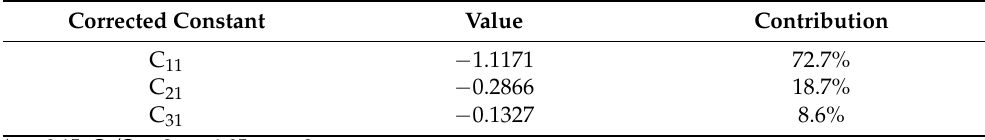
Table 1. Value of corrected constant ( C n 1 ) and its contribution for a triangular hole problem.